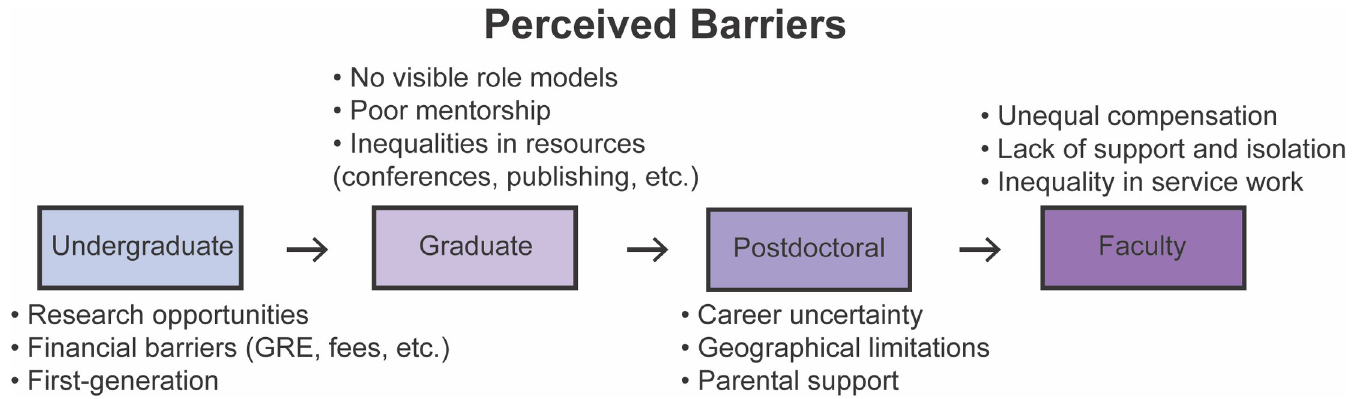
Fig 3. Barriers that were raised by trainees during the ‘Meiosis in Quarantine’ discussion broken down by career stage.